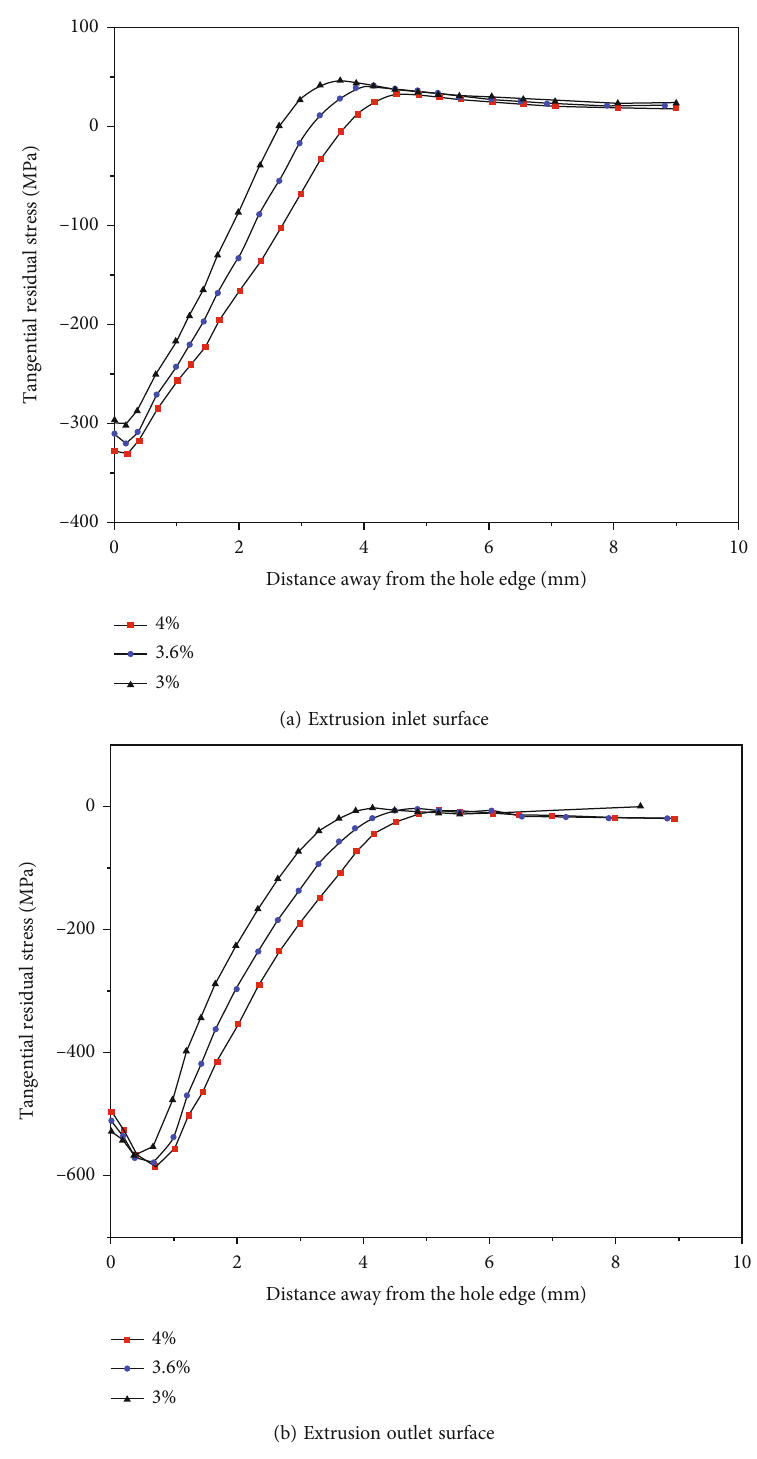
Figure 12: The distribution of tangential residual stress under di ff erent squeezing cold expansion, a large residual compressive stress is intro- Figure 6(b) is a cloud diagram of the tangential residual duced near the hole wall of the material, and the residual stress distribution in cylindrical coordinates. Due to plastic compressive stress reaches the maximum value near the hole deformation near the hole wall after the hole is cold-pressed, wall of the extrusion end. There is a certain depth of residual plastic strain and material spring back will form a tangential tensile stress on the edge of the material squeezed into the residual compressive stress at the edge of the hole. It can be hole. At the same time, the range of compressive residual seen from the fi gure that after the hole is strengthened by